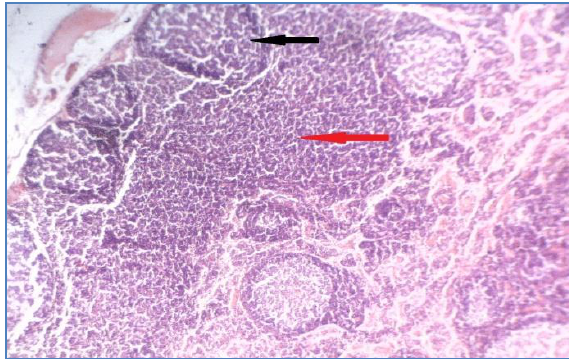
Figure, 8: At 30 day showing: Follicle with germinal center (black arrow) and Follicle without germinal center (red arrow), H and EX100.